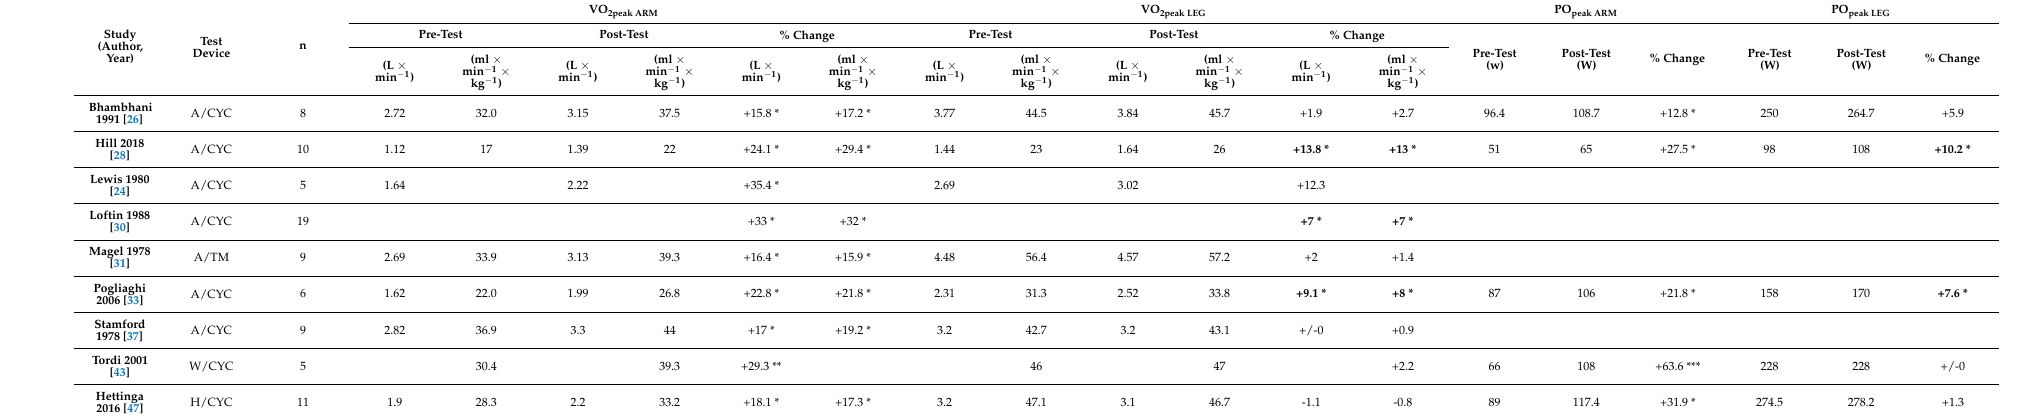
Table 6. Transfer effects on VO 2peak and PO peak from arm training to legs.